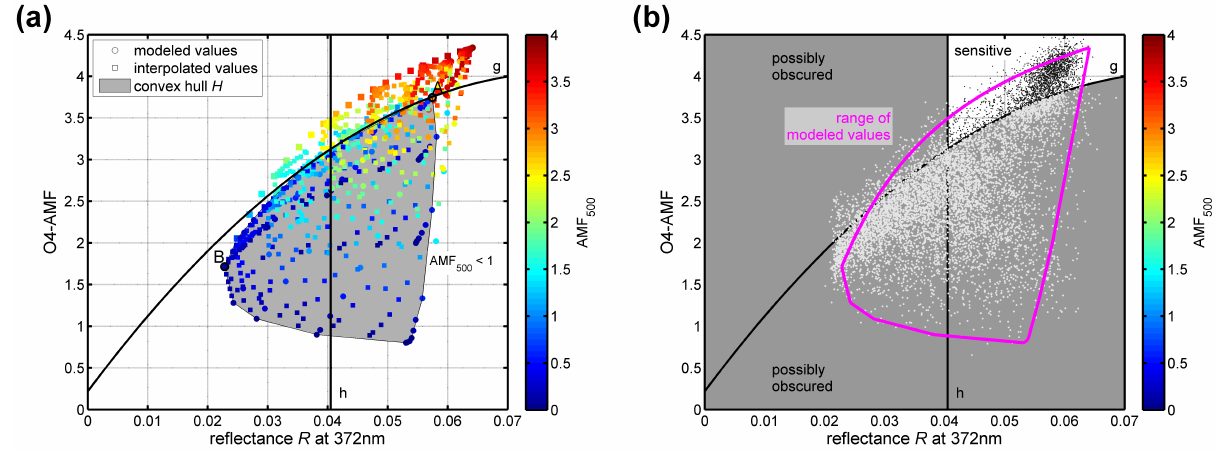
Fig. 7. (a) Modelled and interpolated ( R , A O , A 500 )-triplets for a nadir geometry at SZA = 76 ◦ . The convex hull H (shaded area) including all A 500 < 1 = AMF min is parameterised in order to provide a threshold for the surface sensitivity filter. (b) Classification of all GOME-2 500 = 1. The described filter distinguishes nadir observations of 2008 at the same SZA based on measured R and A O with a threshold of AMF min 500 between measurements sensitive to the lowest 500m of the atmosphere (black dots) and those that are possibly obscured by clouds and/or too low albedo (grey area, bright dots). The convex hull (magenta) of modelled values contains approx. 88% of the measurements.